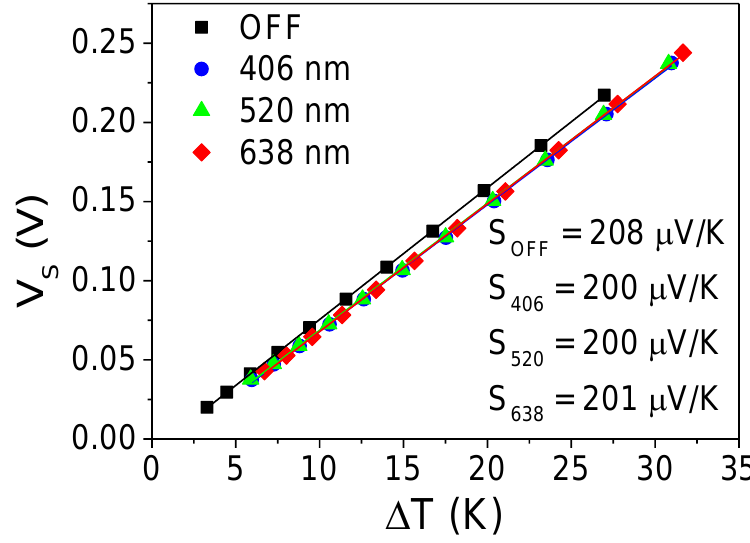
Figure 3. Plot of the open-circuit voltage at and temperature difference as a function of laser power. The inset plot shows the temperature profiles simulated by FEM.